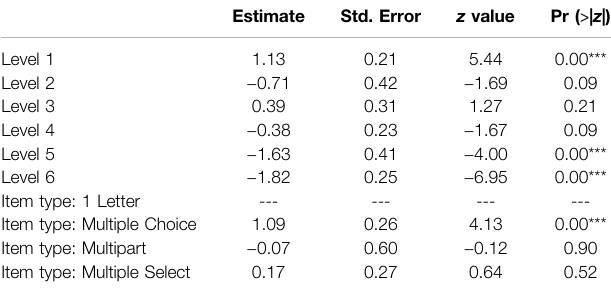
TABLE 7 | Fixed effects estimates for relations and functions LT from model 3.